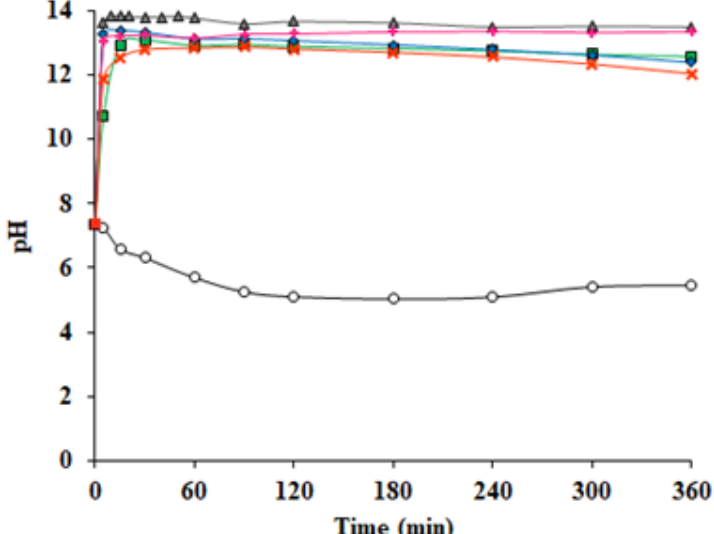
Figure 9. Evolution of pH with time in absence of catalyst ( ), and in presence of the eggshell ( (cid:78) ) and (cid:35) the supported catalysts: Fe 5% ( + ), Fe 15% ( × ), Cu 5% ( (cid:4) ), and Cu 15% ( (cid:7) ). In all cases, T = 150 ◦ C, P = 40 bar, pH = 7.5, initial HA concentration = 400 ppm and catalyst concentration = 1 g / L.